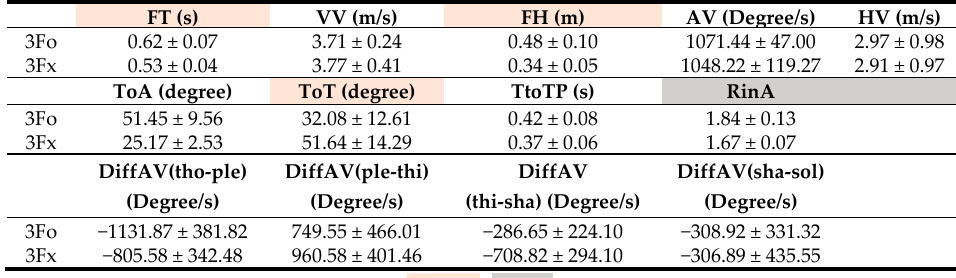
Table 2. Kinematic parameters for 3Fo and 3Fx (Mean ± Standard deviation). Parameters highlighted were found significant different between 3Fo and 3Fx (see definition of 3Fo and 3Fx in Section 2.2; see definition of all thirteen kinematic parameters in Section